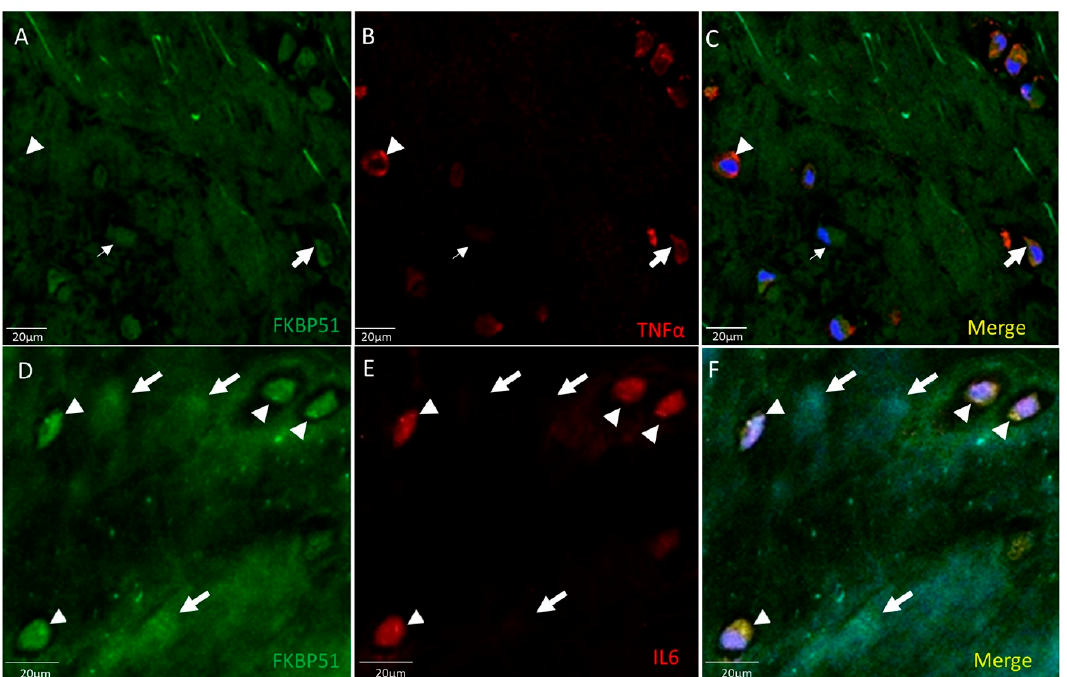
Figure 1. Double immunolabelling for FKBP51 and inflammation markers TNF- α , IL-6, in tibial plateau cartilage sections from a patient with advanced knee OA (grade IV). Merges also contain DAPI labelling. ( A – C ) Chondrocytes labeled by FKBP51 antibody at similar intensity levels. Different TNF- α staining intensity was observed in high (arrowhead), medium (bold arrow), and low (thin arrow) positive cells. ( D – F ) FKBP51+/IL6+ staining in chondrocytes (arrowheads) and in chondrocytes in background (arrows) within lacunae not cut by microtome.